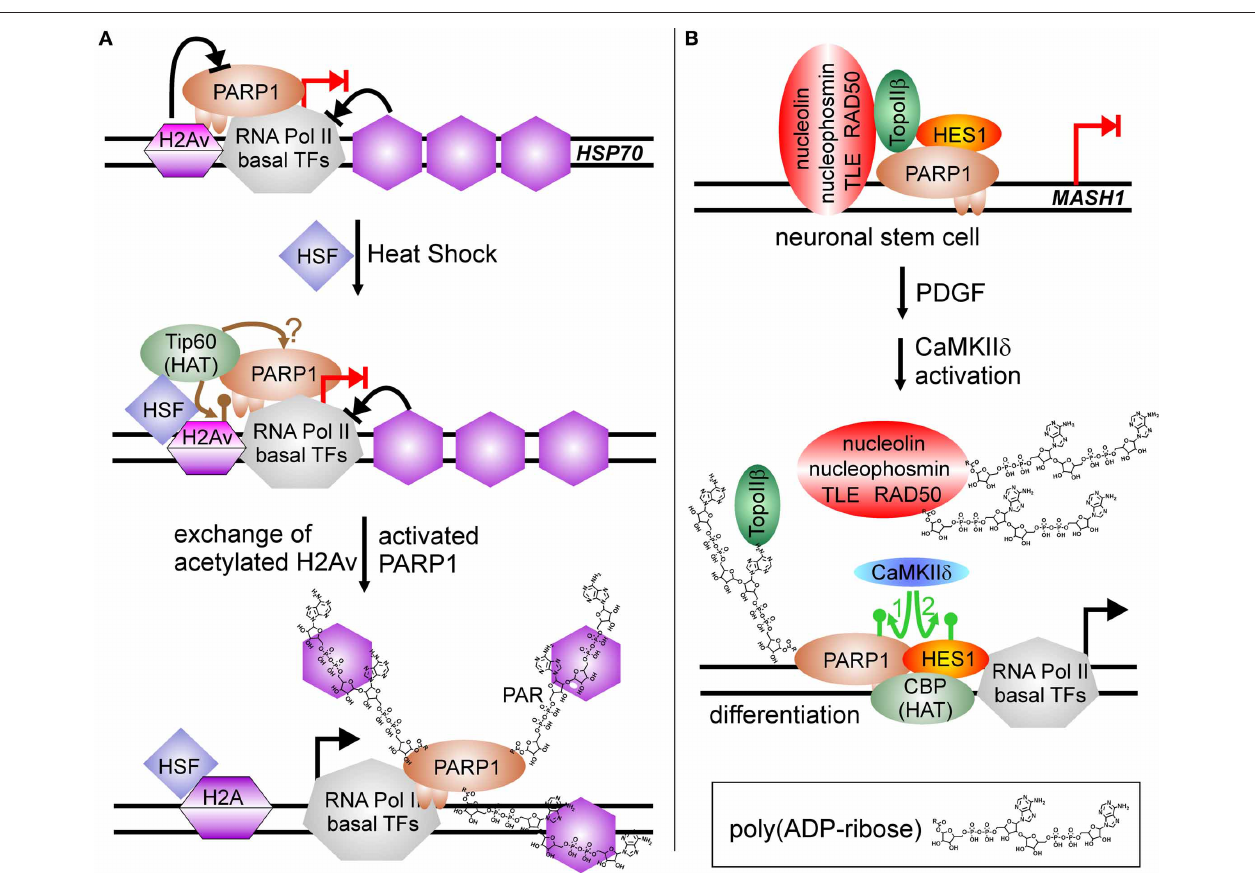
FIGURE 3 | PARP1-activity mediated stimulation of transcription. (A) Chromatin modulation by PARP(1) activity. HSP70 promoter is silenced by incorporated H2A variant (H2Av), blocking PARP(1) activity (blocked black arrow from H2Av to PARP1). RNA Pol II complex is assembled at promoter and poised for transcription, but specific nucleosome positioning halts RNA Pol II activity (blocked black arrow from nucleosomes to RNA Pol II). Heat shock induces the translocation of HSF (heat shock factor) to the HSP70 promoter and recruits the histone acetyl-transferase Tip60, which induces replacement of H2Av against standard H2A by acetylation (brown lollypop). Putatively, it could also target PARP1, similar to the situation at NF κ B-regulated promoters. Activated PARP1 is released from the promoter